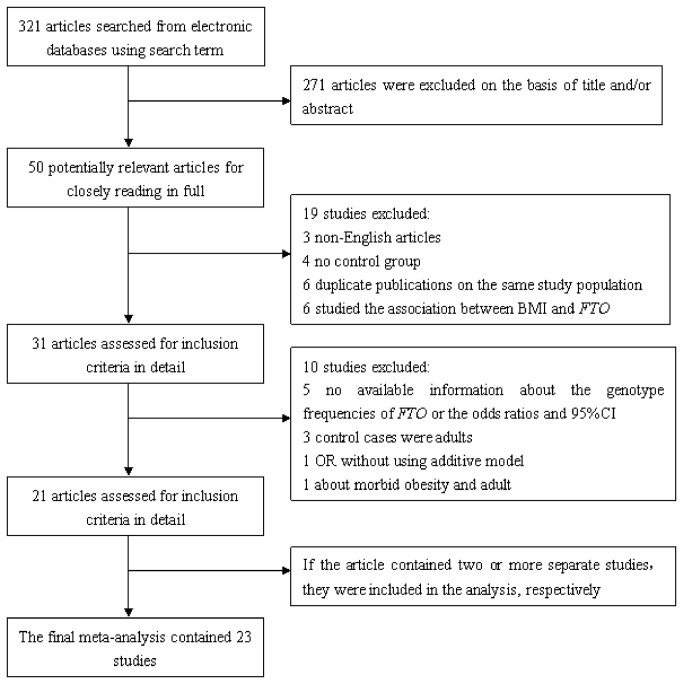
Flow chart of article selection for meta-analysis.